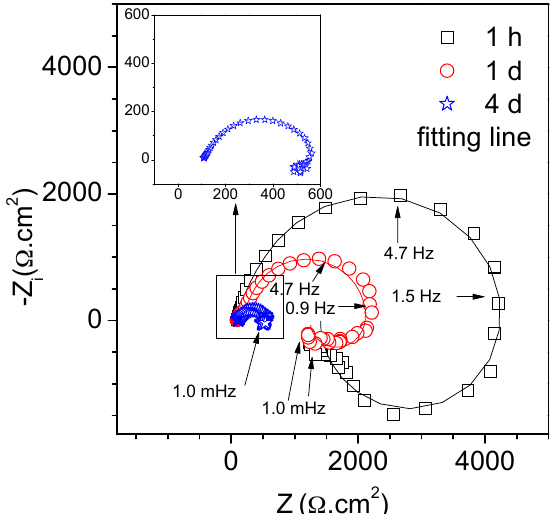
Figure 5. Examples of Nyquist diagrams with respective fi tting line for AZ31B samples after 1 hour, 1 and 4 days of immersion at open circuit potential in Ringer ′ s solution (37 °C).